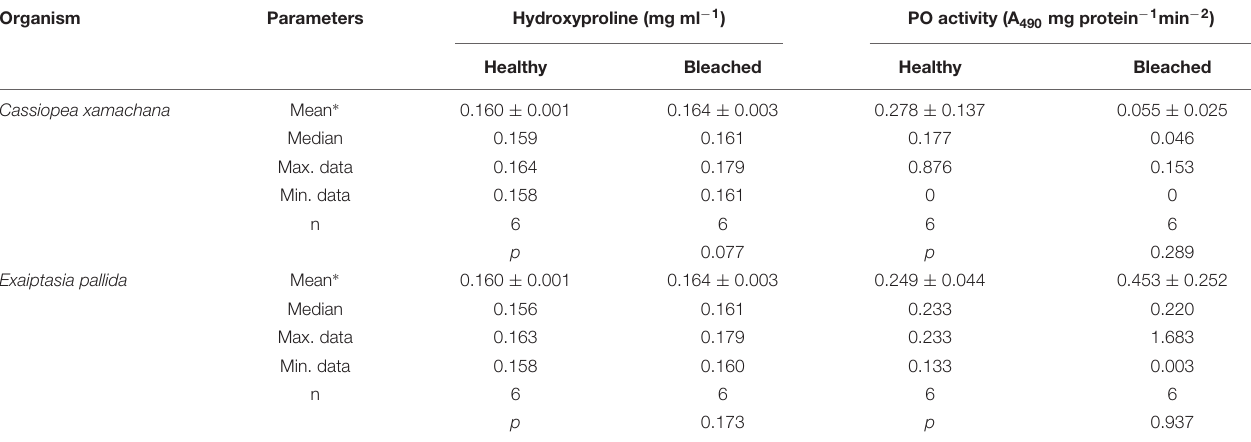
TABLE 4 | Total hydroxyproline and phenoloxidase (PO) activity levels of the mucus complex samples collected from healthy and bleached C. xamachana and E. pallida. Organism